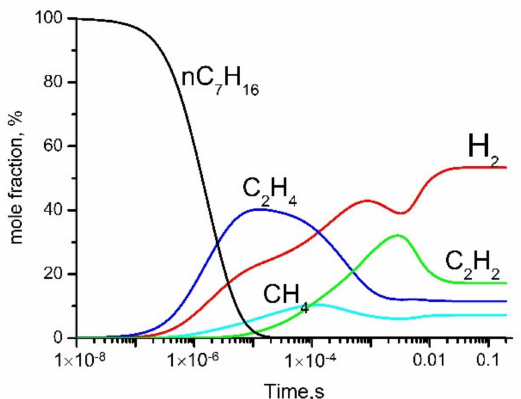
Figure 15. Evolution of gas phase products. Simulation at T = 1500 K, p = 1 atm.